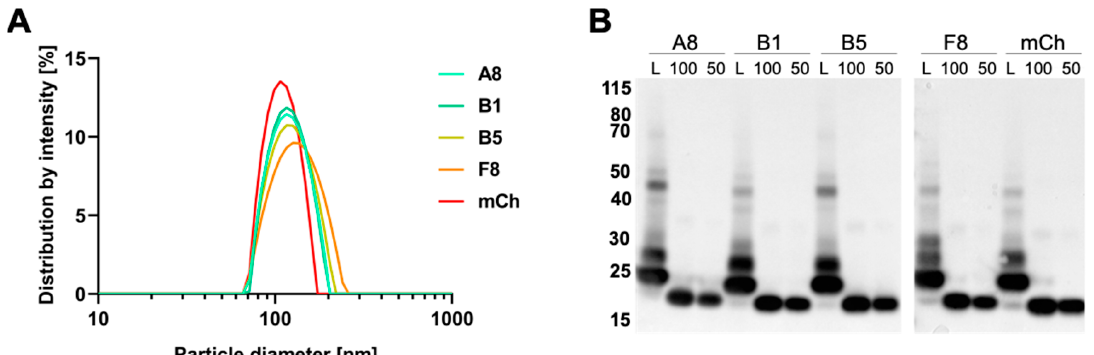
Figure 4. Characterization of vincristine-loaded targeted liposomes. ( A ) Size distribution of sdAb-coated liposomes measured by dynamic light scattering. ( B ) Western blot analysis of coupled sdAb. Liposome suspensions (L) equivalent to 100 ng of sdAb were loaded under reducing and denaturing conditions for gel electrophoresis. Amounts of 100 ng and 50 ng of uncoupled protein were loaded as control. SdAb were detected with an anti-6xHis-tag antibody. Table 2. Characterization of FGFR4-targeting and vincristine (VCR)-loaded liposomes. Liposomes Characteristics